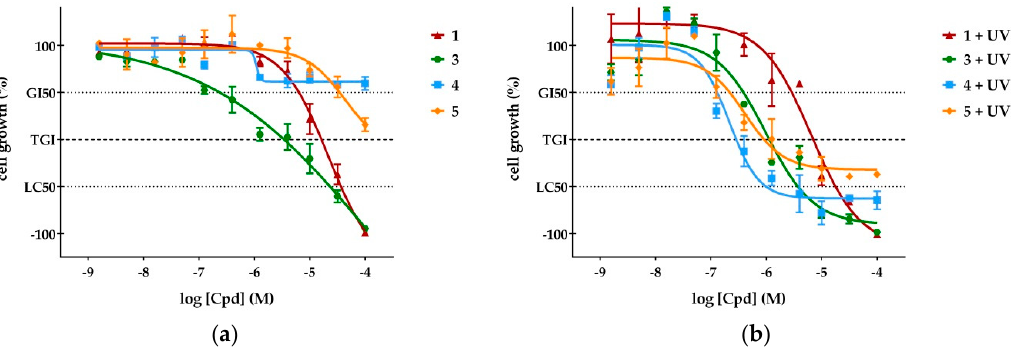
Figure 7. Antiproliferative activity of tested compounds on VEGFR-2 dependent PC-3 cells. ( a ) Dose − response curves of active inhibitors ( 1 and 3 ) and their corresponding caged compounds ( 4 and 5 ) were determined without UV irradiation. Cell growth was measured 48 h after incubation with the compounds. The caged derivatives do not exhibit cytotoxic activity: the TGI mark is not reached even at high concentrations; ( b ) Cells were incubated for 1 h with the compounds and then irradiated at 365 nm (1.1 kW/m²) for 5 min. Cell growth was determined 48 h after incubation with the compounds. After irradiation, the caged derivatives show similar ( 5 ) or even left shifted ( 4 ) dose − response curves as that of active compounds. GI50 = 50% growth inhibition; TGI = total growth inhibition; LC 50 = 50% lethal concentration; n = 4. Error bars represent standard deviation. The effect of UV irradiation on the PC-3 cells is shown in Supplementary Figure S4. Table 2. Antiproliferative activity of tested compounds in cellular growth assays with PC-3 cells, without and after irradiation at 365 nm (1.1 kW/m 2 ). The GI 50 values (50% cellular growth inhibition) are presented. “Not reached”: The tested compound did not inhibit the cell growth to 50%.